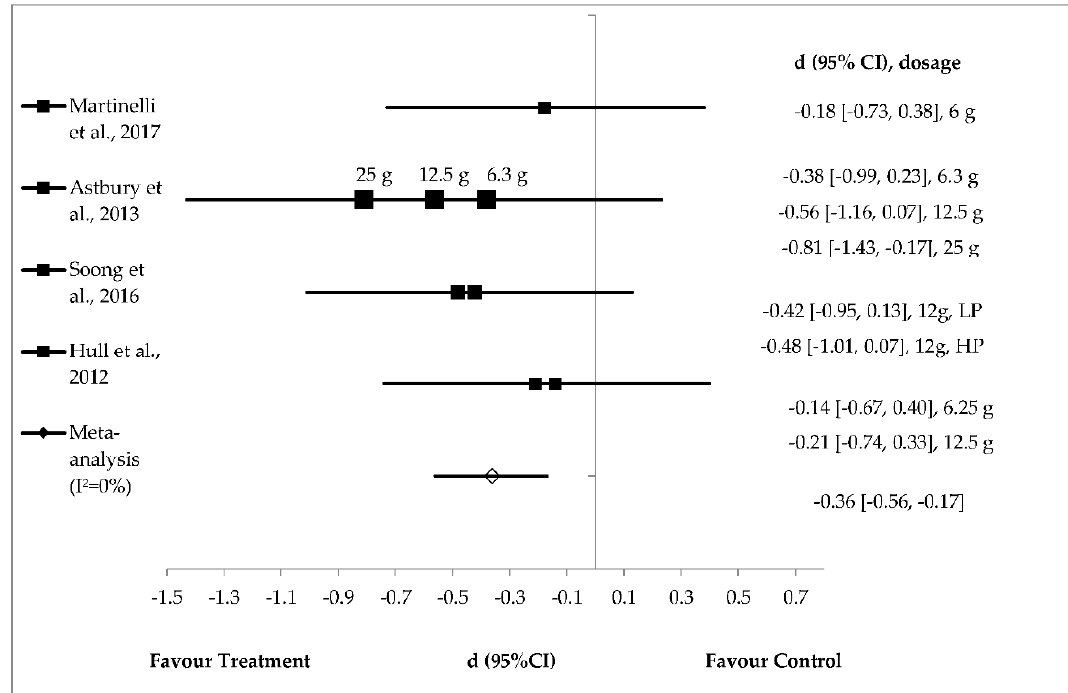
Figure 7. Effects of polydextrose on energy intake reduction (fixed effects model). The axis lines on ±0.2, ±0.5 and ±0.8 represents small, medium and large effect sizes respectively. A negative value of summary effect size suggests that polydextrose supplementation decreases energy intake compared to control. d = effect size; CI = confidence interval; LP = low protein; HP = high protein.